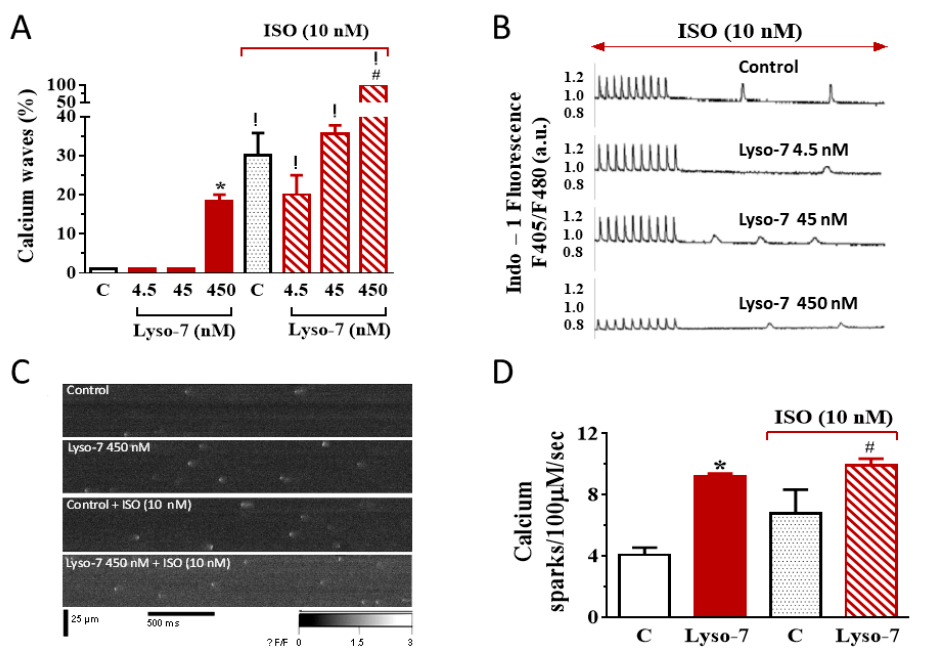
Figure 7. Acute in vitro effect of Lyso-7 on cardiomyocytes’ abnormal spontaneous diastolic Ca 2+ events under IsoproTable 10. nM) challenge. ( A ) percentage of cardiomyocytes developing at least one spontaneous Ca 2+ wave in the absence (left panel) and presence (right panel) of Isoproterenol (ISO, 10 nM) during resting periods after a train of field stimulation at 1 Hz in cardiomyocytes. ( B ) Representative recordings of Ca 2+ waves under ISO. n = 12–18 cells. ( C ) Typical line-scan confocal images of Ca 2+ sparks from Fluo-4-AM loaded cardiomyocytes; n = 7–10. ( D ) Mean of frequency of Ca 2+ sparks measured in the different conditions indicated. C = Control refers to the absence of Lyso-7 (450 nM). We used a t -test. p < 0.05, * Lyso-7 vs. Control in the absence of ISO (left part of the panel); # Lyso-7 vs. Control in the presence of ISO (right part of the panel); ! with ISO vs. without ISO.